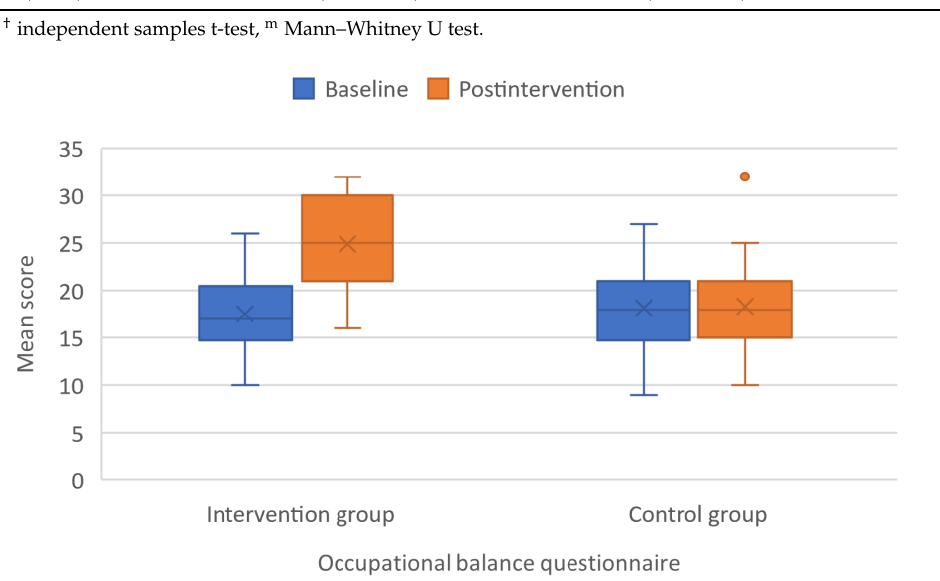
Figure 2. Boxplot with error bars showing mean scores of Occupational Balance Questionnaire (OBQ11) at baseline and after intervention .